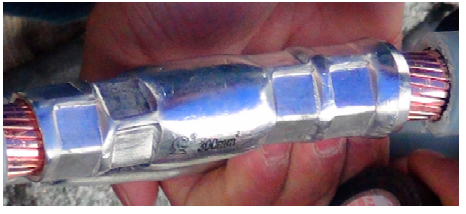
Figure 20. Connectors pressed with four indentations.